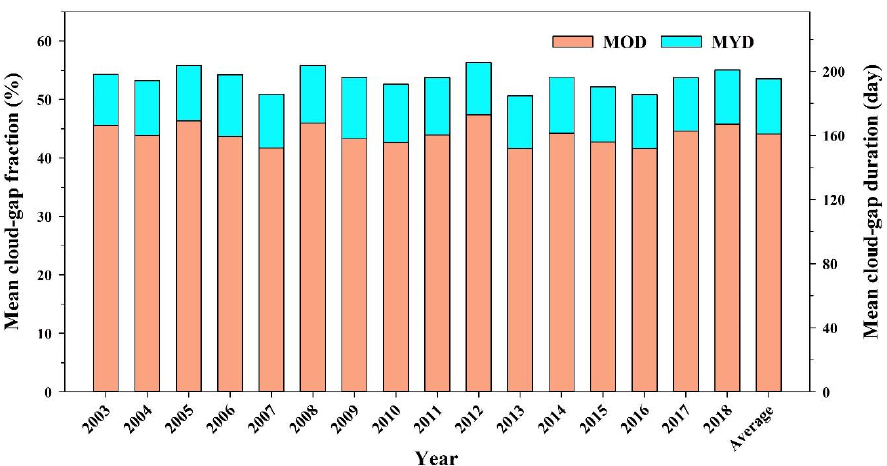
Figure 7. Mean cloud ‐ gap fraction and cloud ‐ gap duration of the MODIS NDSI products from 2003 to 2018. MOD and MYD refer to MOD10A1 and MYD10A1 products, respectively.